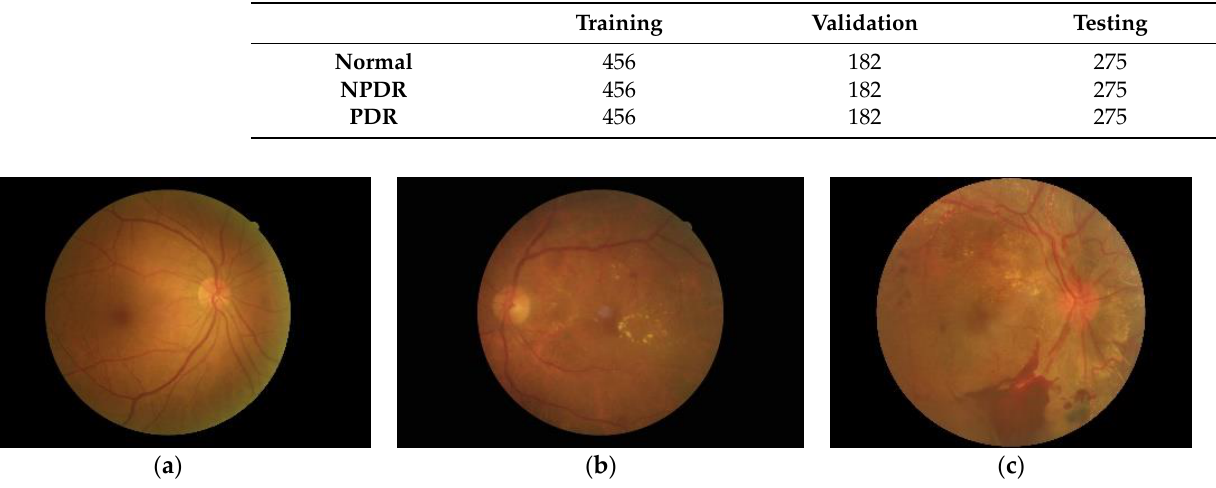
Figure 4. Example of DDR dataset: ( a ) normal; ( b ) NPDR; ( c ) PDR. Table 1. DDR dataset composition.